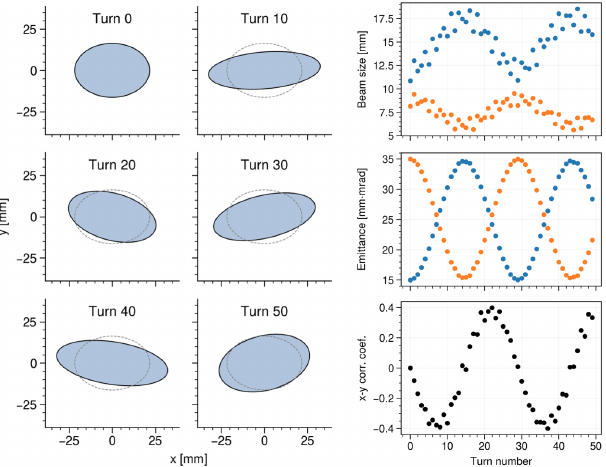
FIG. 4. Turn-by-turn mismatch oscillations of the Danilov distribution at the entrance of an uncoupled FODO lattice. The beam would be matched to the lattice without space charge. Right column: blue (orange) corresponds to the x ( y )